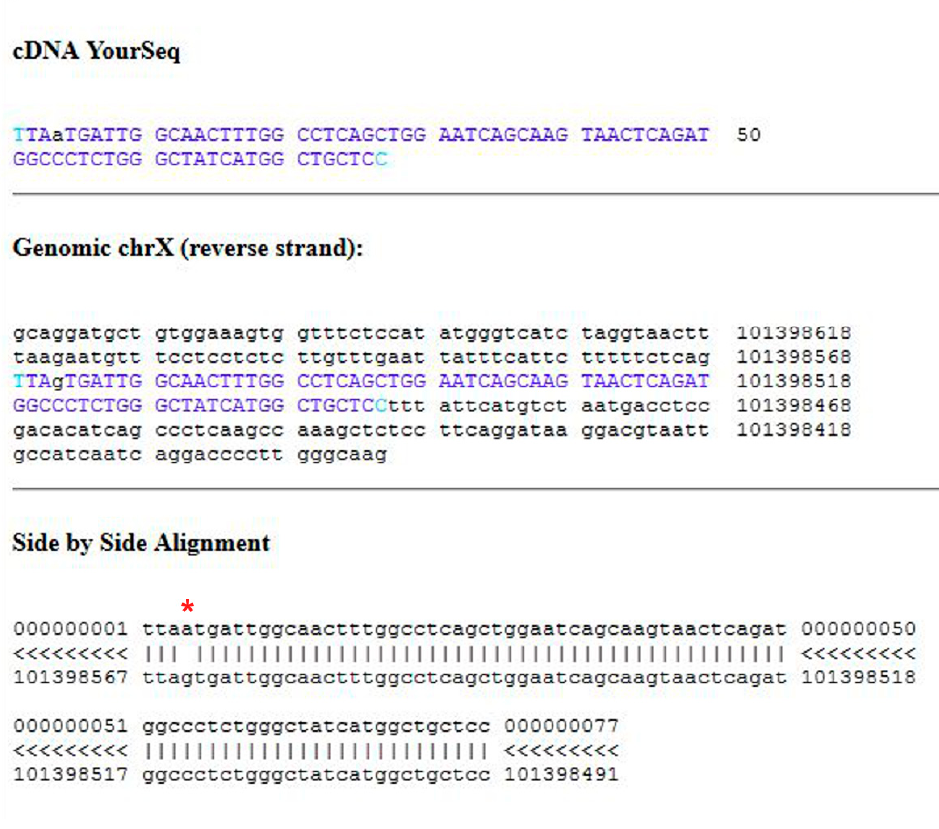
Figure 1. Alignment of the patient’s sequence with the reference genome using BLAT. The transition observed in the GLA gene is indicated by an asterisk.